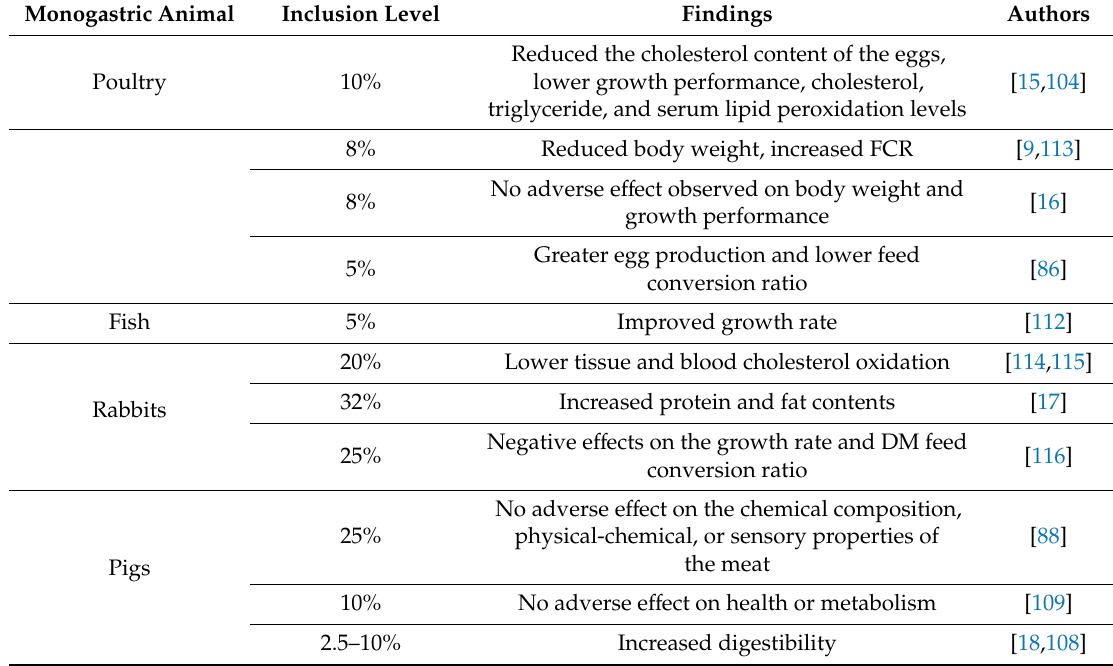
Table 5. E ff ect of amaranth grain in diets of monogastric